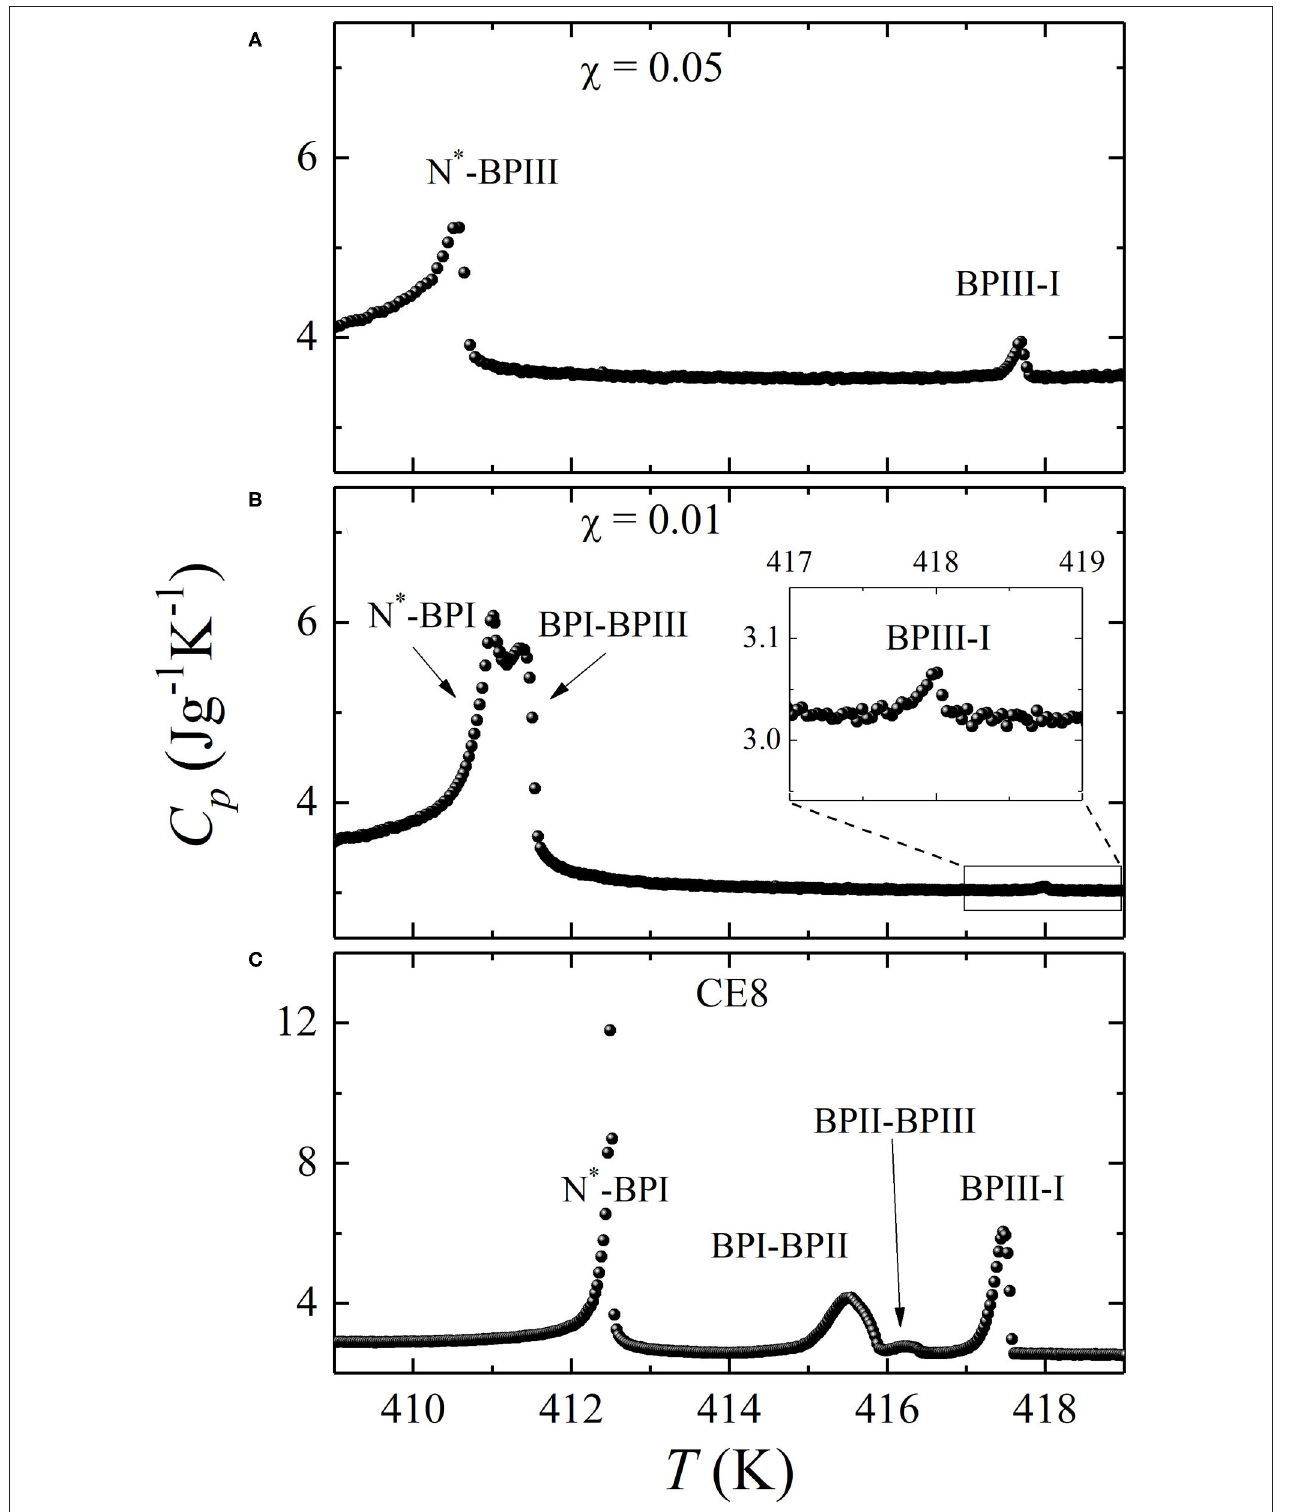
FIGURE 2 | Heat capacity temperature profiles C p (T) obtained by ac calorimetry for two mixtures of chiral liquid crystal CE8 and CdSSe QDs. Top layer (A) : χ = 0.05. Middle layer (B) : χ = 0.01. Bottom layer (C) : pure CE8 (from Ref. [44]). The inset in layer (B) shows a blow-up of the temperature regime around BPIII-I anomaly, which is greatly suppressed and barely visible in the full-scale